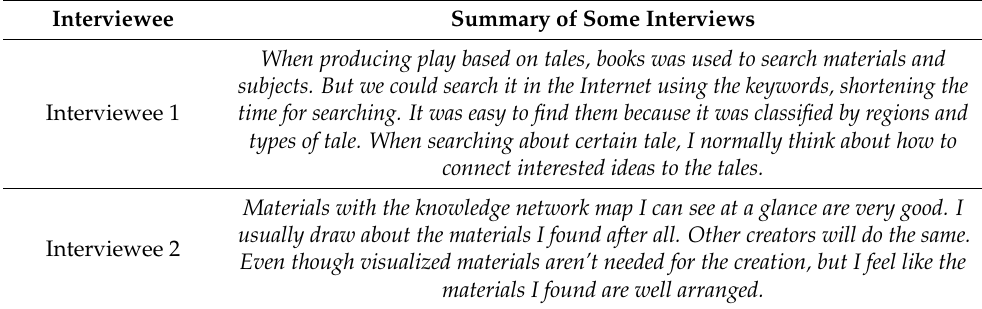
Table 5. Summary of some